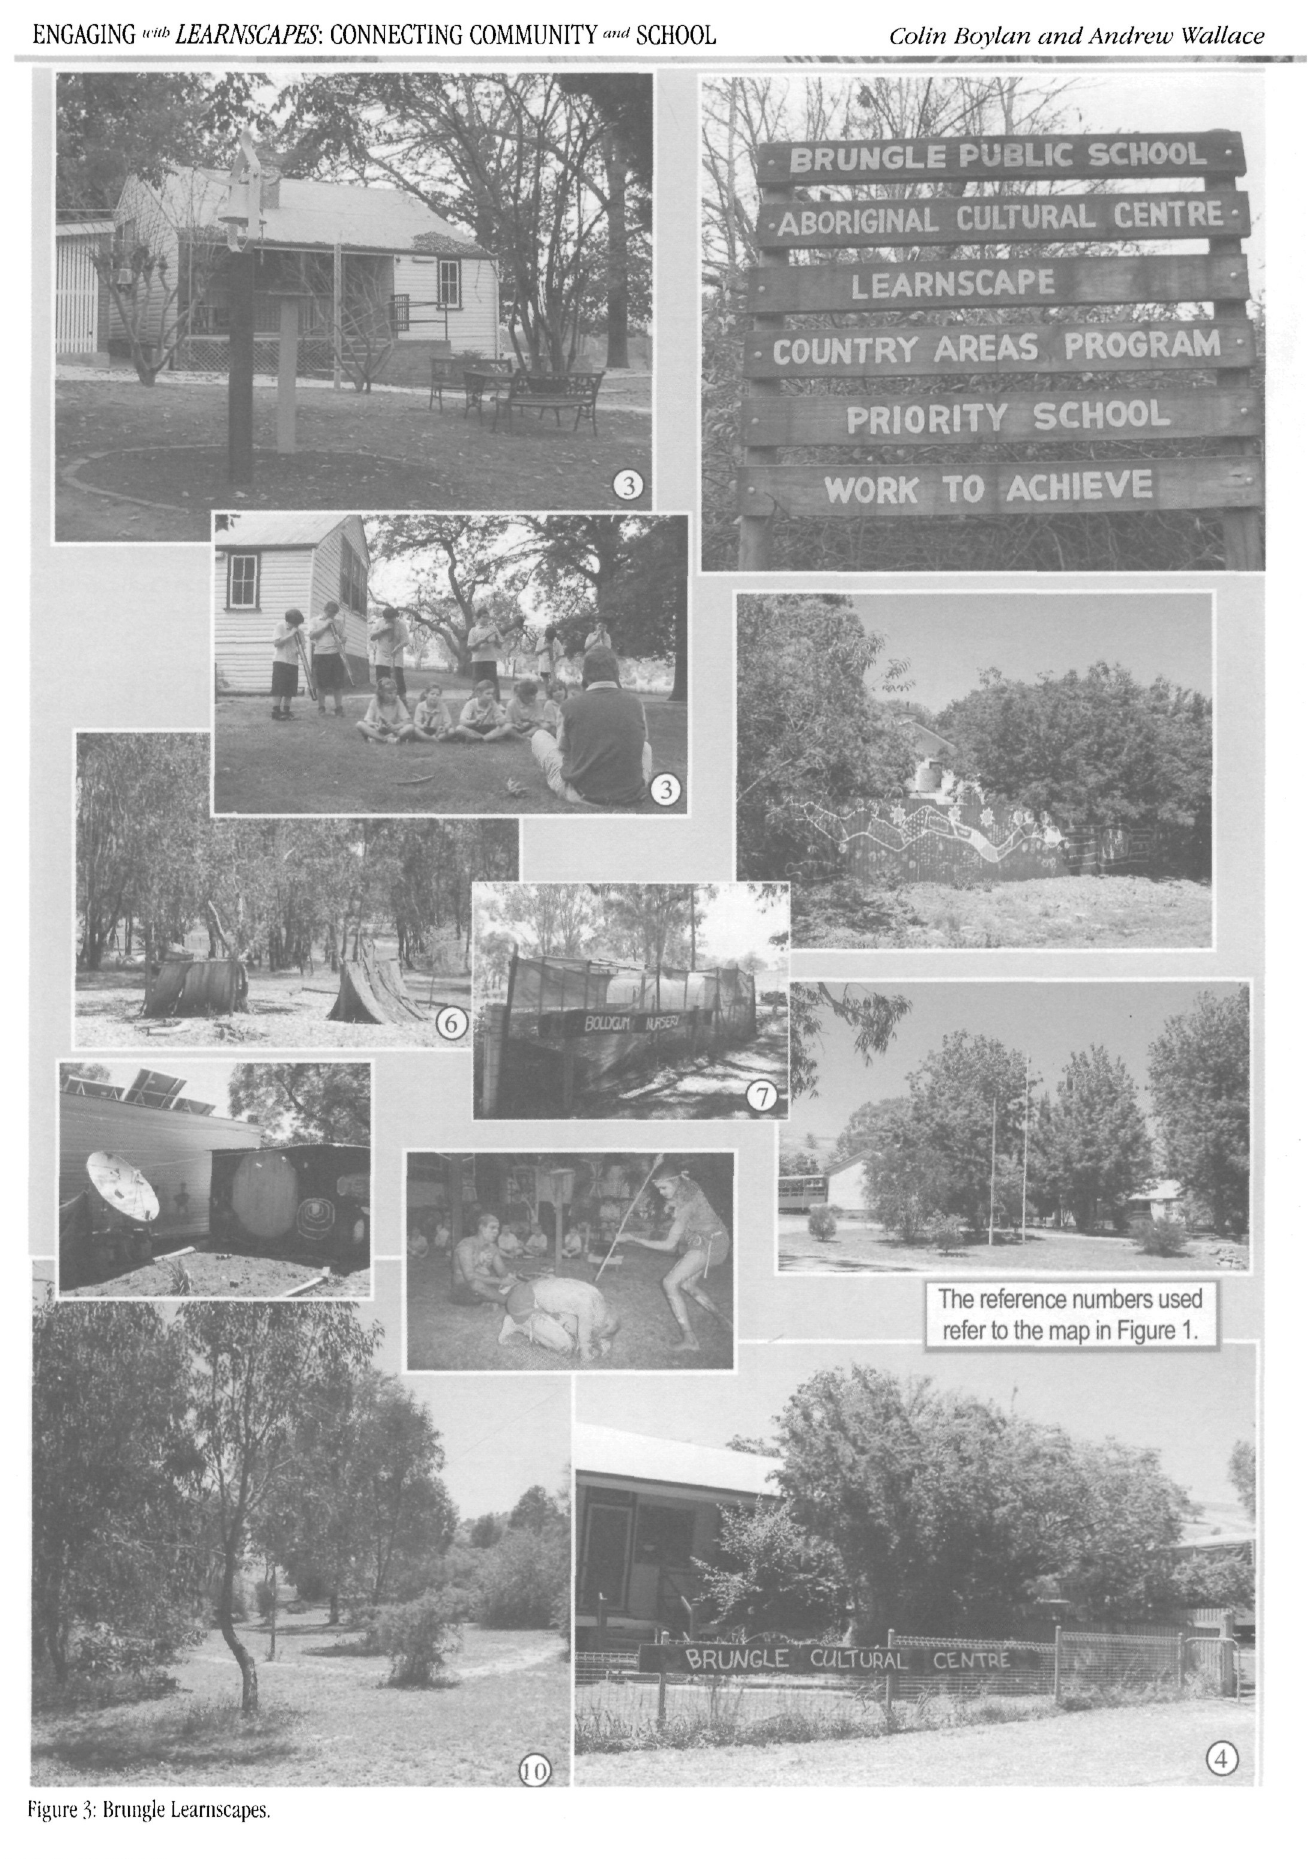
Figure 3: Brungle